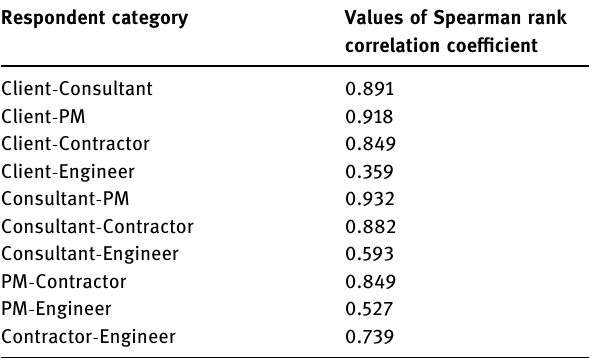
Table 5: Spearman rank correlation coe ffi cients of overall cate - gories of respondents